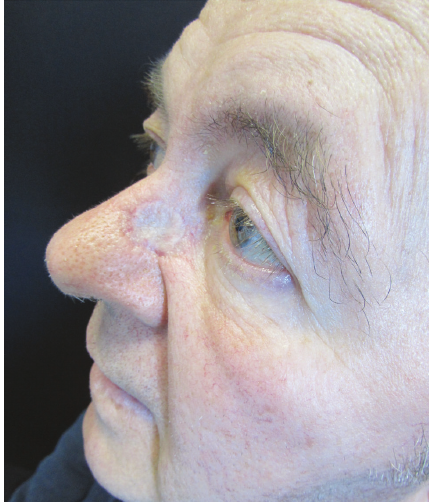
Figure 9: Complete healing of the defect after STSG in group